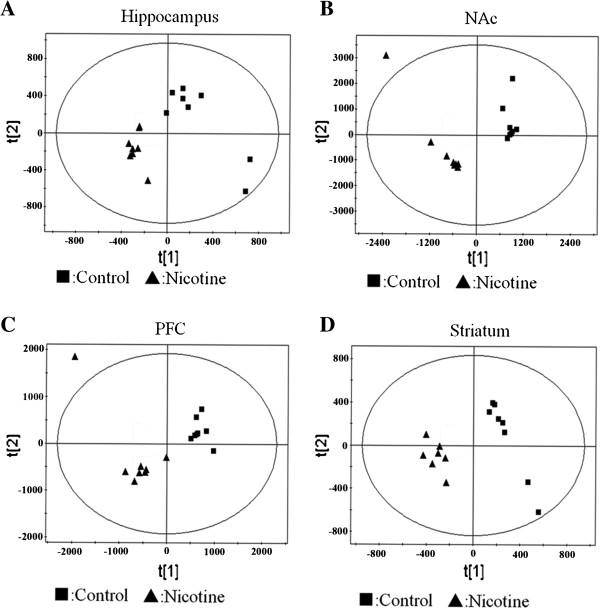
PLS scores plots and OSC-PLS scores plots of brain regions from mice: (A) hippocampus; (B) NAc; (C) PFC; (D) striatum.